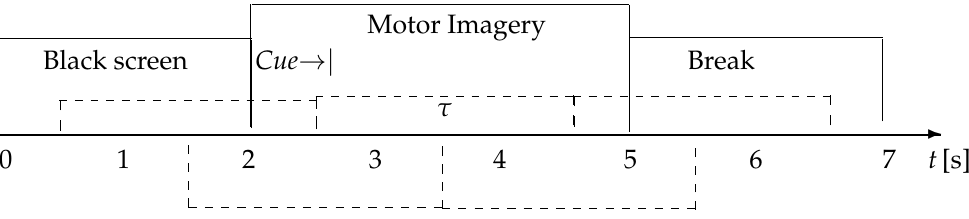
Figure 3. GigaScience database timeline of the evaluated motor imagery paradigm.